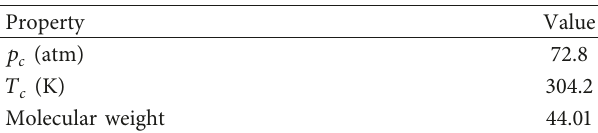
Figure 4: Model description: aquifer, caprock, and overburden. The injector is perforated in bottom three layers of the aquifer. Table 2: CO 2 component